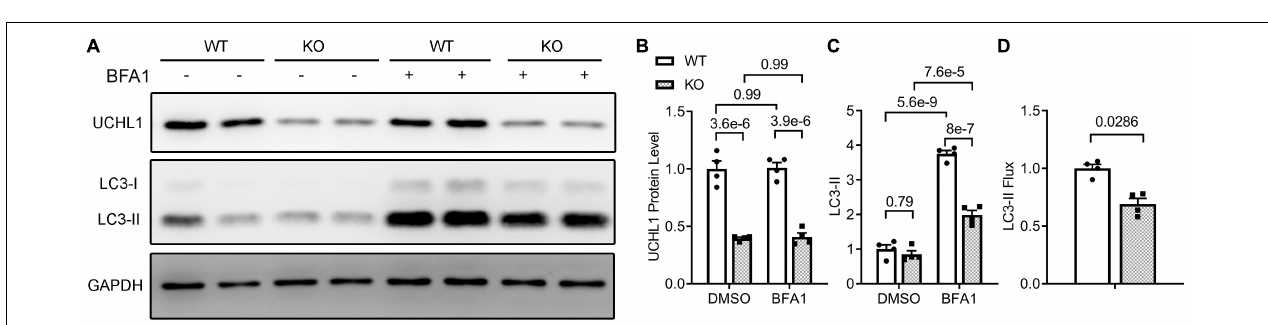
FIGURE 9 | Cardiomyocyte-restricted Uchl1 deficiency decreases myocardial LC3-II flux in mice. Adult female Myh6-Cre transgenic (CTL) and Myh6-Cre:Uchl1 flox / flox (CKO) mice were subjected to an intraperitoneal injection of bafilomycin-A1 (BFA1) or vehicle control (DMSO) and, 1 h later, ventricular myocardium was collected for total protein extraction and Western blot analysis for the indicated proteins. The total protein signals from the stain-free imaging were used as the in-lane loading control. Representative images (A) and pooled densitometry data (B,C) of Western blot analyses for the indicated proteins. Two-way ANOVA followed by Tukey’s test were used. (D) Relative myocardial LC3-II flux. The mean value of LC3-II levels in the DMSO treated group of a genotype was used as the baseline LC3-II value to subtract the LC3-II value of each BFA1 treated mouse in the same genotype groups, and the difference is regarded as the LC3-II flux for the mouse. The mean value of LC3-II flux values of the CTL group is then used to normalize all LC3-II flux values, the resultant relative LC3-II flux values are plotted in panel (D) . Two-tailed unpaired t -test was used for panel (D) .